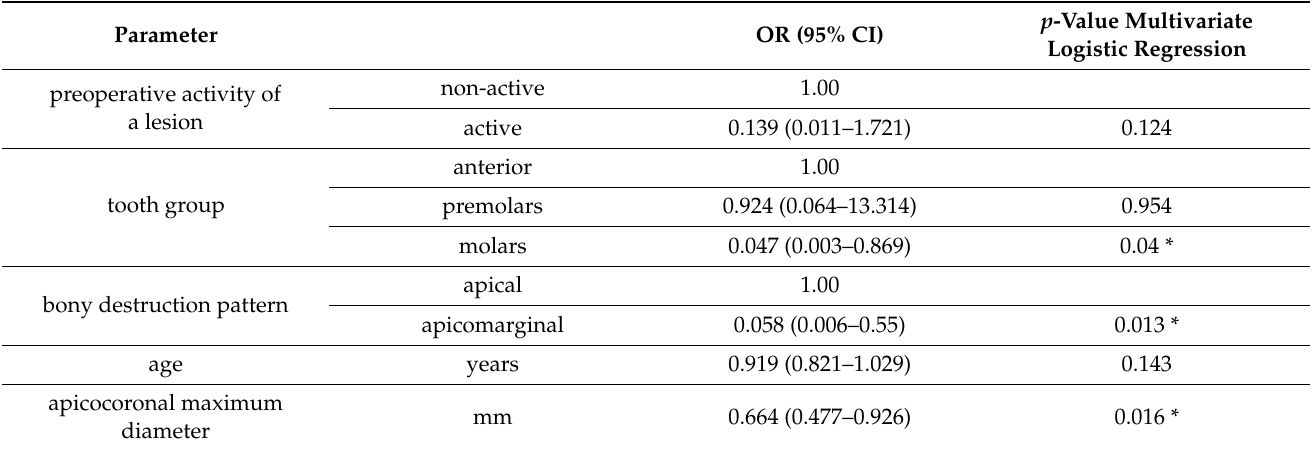
Table 4. Multivariate logistic regression model.